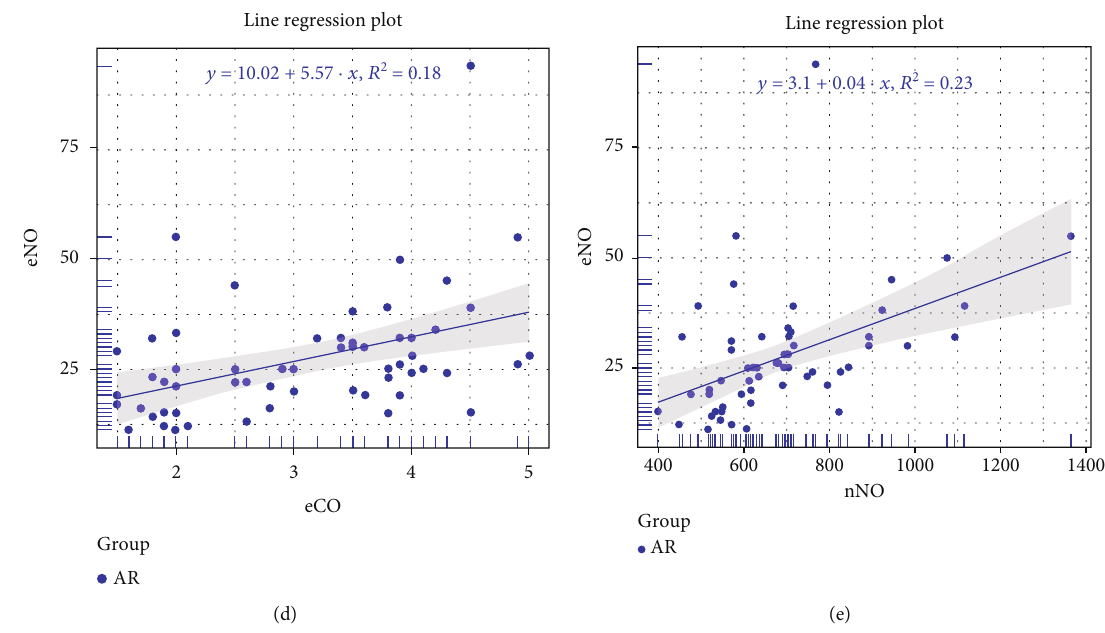
Figure 1: (a) Comparison of the nNO, eNO, and eCO levels between the AR group and control group ( x ± s ); (b) comparison of the nNO, eNO, and eCO expression levels ( x ± s ); (c) correlation analysis of nNO and eCO, R 2 = 0 : 21 , p < 0 : 01 ; (d) correlation analysis of eNO and eCO, R 2 = 0 : 18 , p < 0 : 01 ; (e) correlation analysis of eNO and nNO, R 2 = 0 : 23 , p < 0 : 01 under the curve AUC = 0 : 786 , p < 0 : 001 , and ( AUC = 0 : 577 , p = 0 : 445 ) (Figure 4). As an indicator for auxiliary diagnosis,